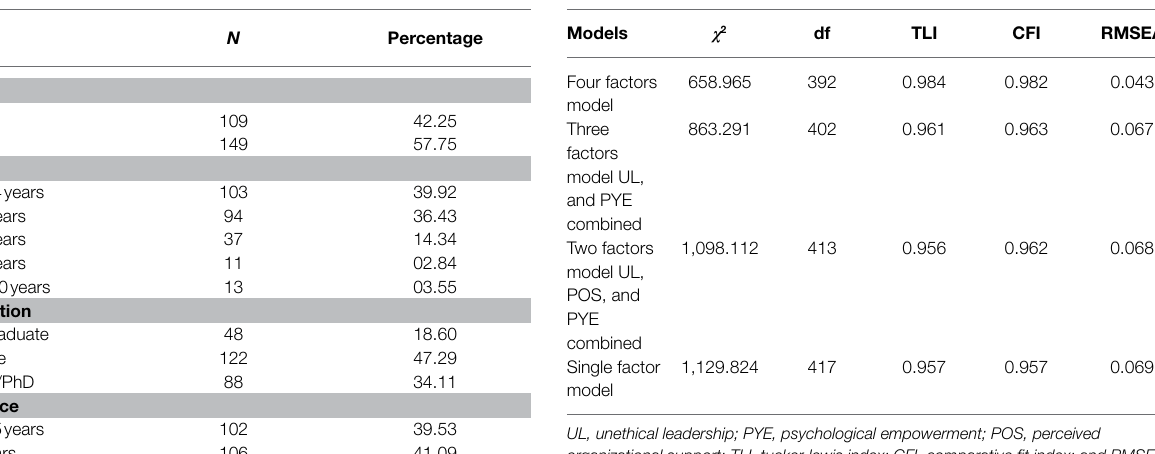
TABLE 3 | Results of confirmatory factor